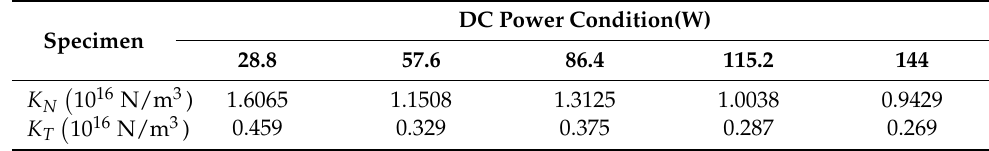
Table 2. The results of the stiffness coefficients according to deposition condition.